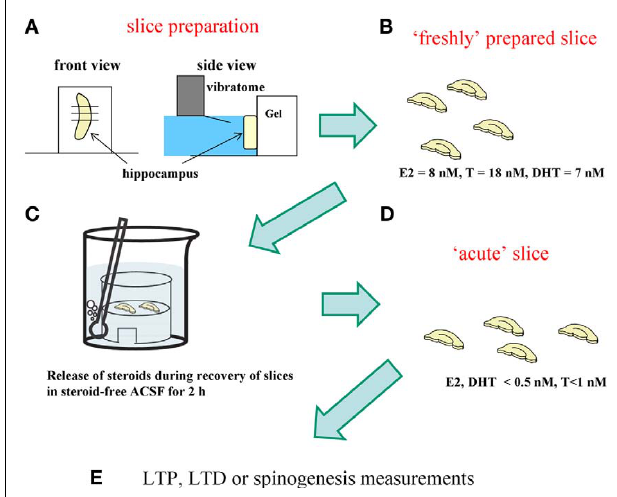
FIGURE 5 | Difference between “freshly isolated hippocampus” and “acute” hippocampal slices. For analysis of spinogenesis or electrophysiological experiment, “acute“ hippocampal slices are prepared according to the following procedure. (A) Hippocampus is sliced by 400 μ m-thickness with a vibratome (Dosaka, Japan). (B) Hippocampal slices immediately after slice preparation contain the identical level of sex steroids and corticosteroids to that in the hippocampus in vivo . (C) During 2h recovery in ACSF, hippocampal sex steroids, and corticosteroids diffuse into ACSF. (D) After recovery, hippocampal concentration of steroids decreases to below 0.5nM for E2 and DHT, 1nM forT, and 2nM for CORT, respectively.These hippocampal slices are “acute” hippocampal slices. (E) For analysis of spinogenesis or electrophysiological experiment, “acute” slices are usually